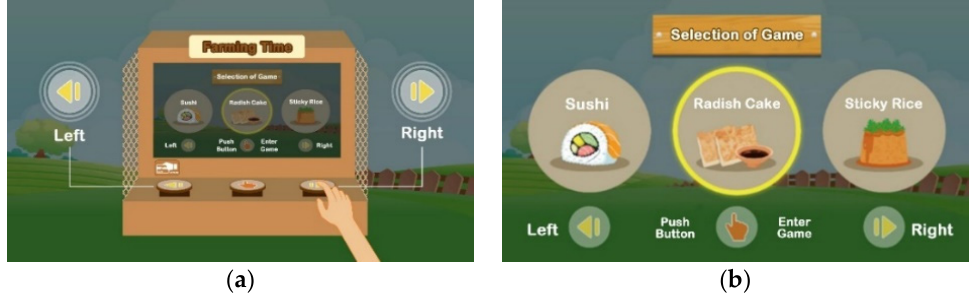
Figure 3. Use of buttons on the tangible panel for selecting and starting games. ( a ) Selecting a game by using the left or right buttons. ( b ) Confirming a selected game and starting it.